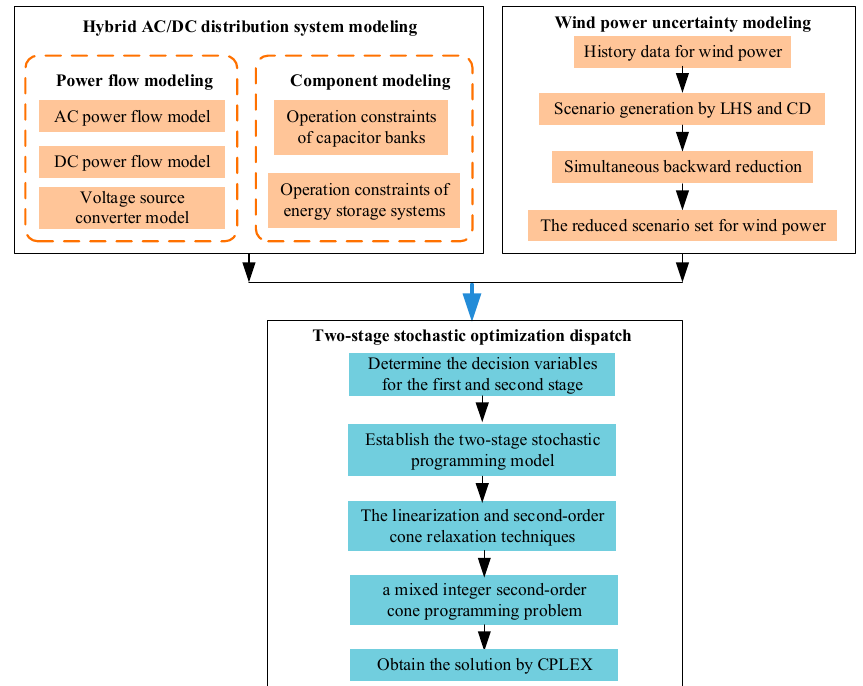
Figure 1. The schematic framework of this study.